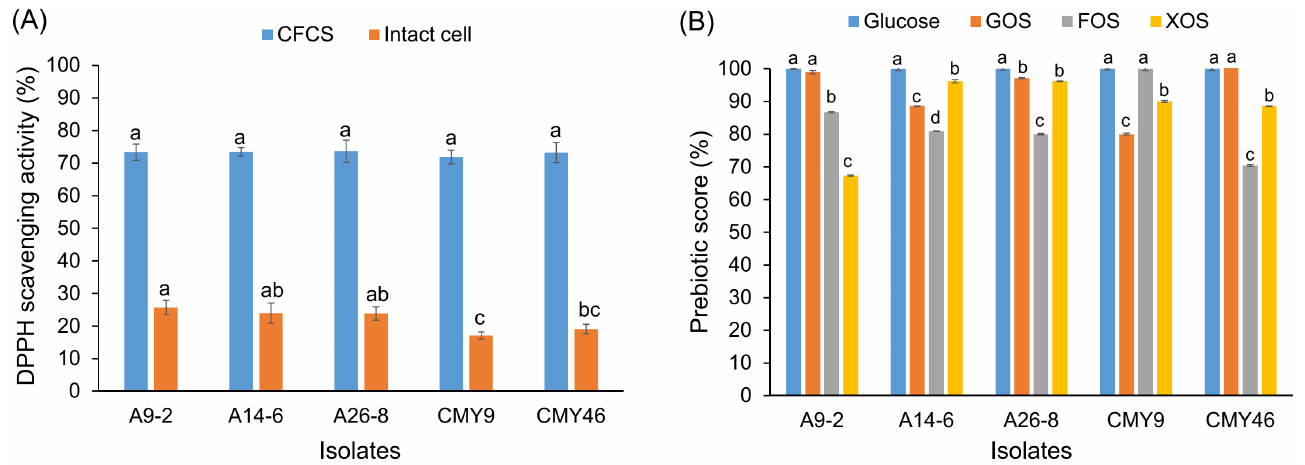
Figure 5. DPPH scavenging activity ( A ) and prebiotic scores ( B ) of L. plantarum A9-2, L. pentosus A14-6, L. pentosus A26-8, P. pentosaceus CMY9, and L. pentosus CMY46. Different letters (a–c) indicate significant differences of the values ( p < 0.05).